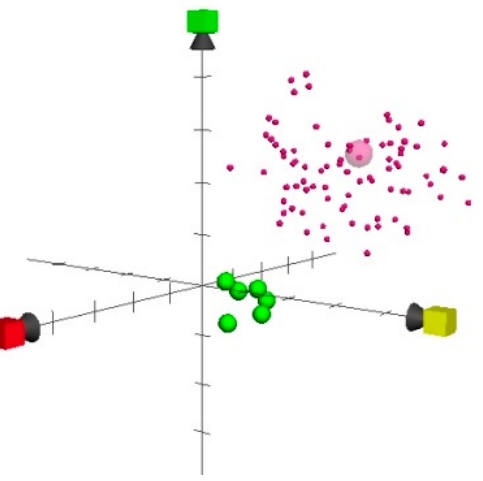
Figure 2. Position of bedaquiline (large pink sphere), the 100 closest antituberculosis compounds (small spheres), and quinoline compounds (green spheres), using ChemGPS-NP scores, where PC1 (x = red), PC2 (y = yellow), and PC3 (green).